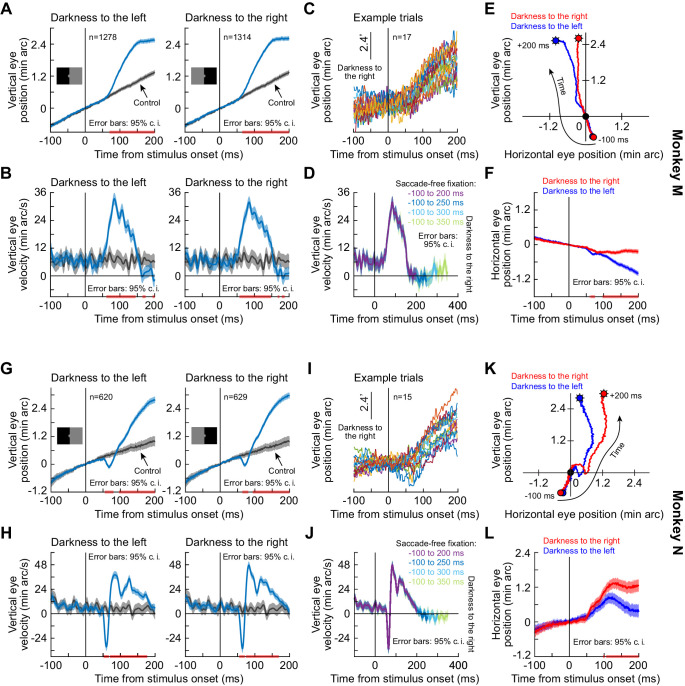
Short-latency, stimulus-driven ocular position drift response in two additional monkeys besides the monkey shown in Figure 1.This figure is formatted identically to Figure 1. It shows very similar results from two additional monkeys, M and N. (A–F) Monkey M results. (G–L) Monkey N results. Error bars are defined in all relevant panels. The pink horizontal lines on various x-axes denote intervals in which the 95% confidence intervals around the two compared curves did not overlap.